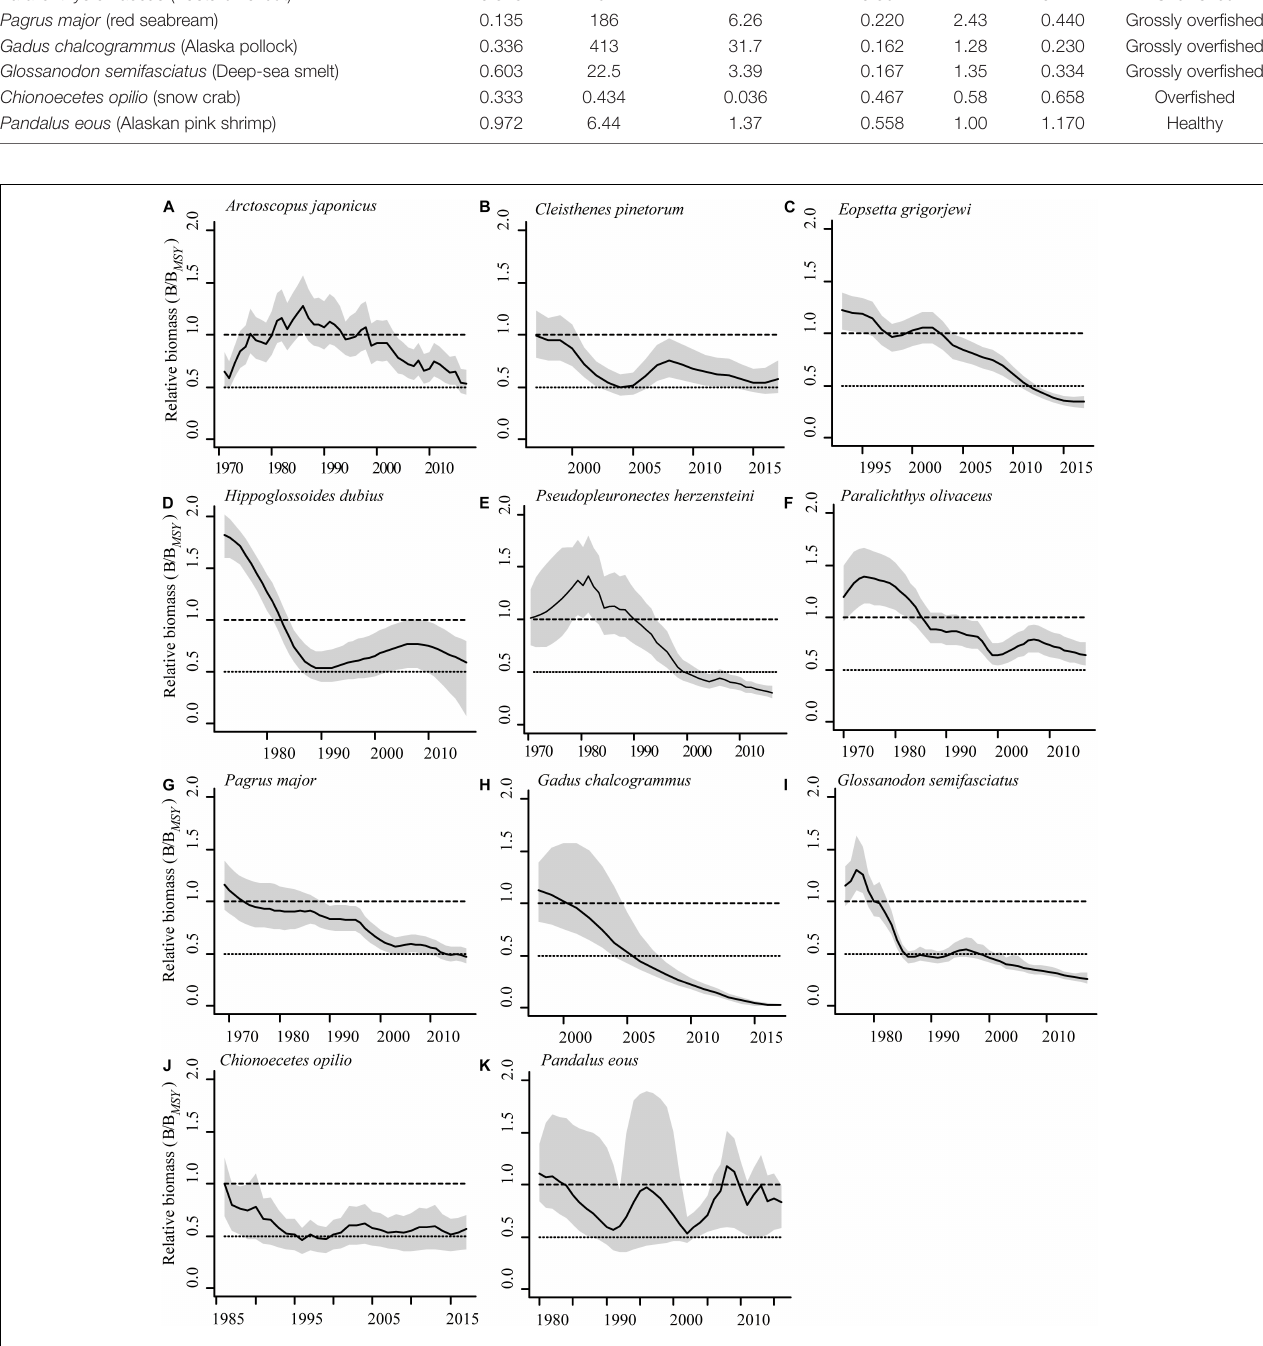
FIGURE 2 | Trajectories of relative total biomass ( B / B MSY ) of 11 stocks in the Japan Sea.